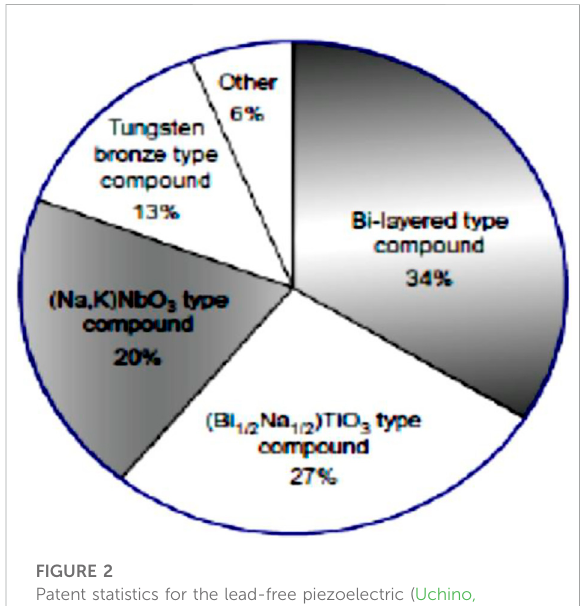
FIGURE 2 Patent statistics for the lead-free piezoelectric (Uchino, 2010).